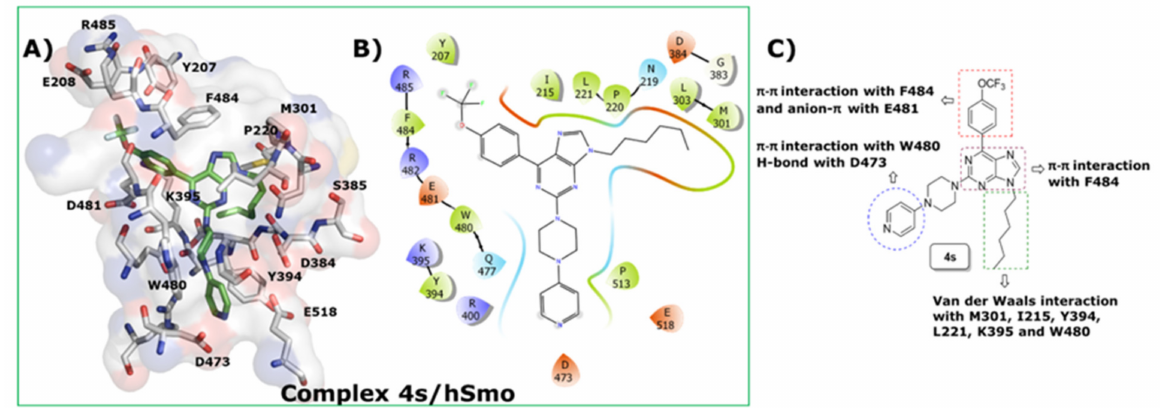
Figure 6. Predicted binding mode of 4s (green) within the α -heptahelical bundle of the hSMO receptor (PDB ID: 4QIN). ( A ) 3D representation of hSMO in complex with 4s ; residues (less than 5.0 Å) are shown in white stick representation. ( B ) 2D representation of 4s in a complex with hSMO. ( C ) Main interactions in the 4s -hSMO complex. Areas of the molecular structure of 4s which are important for its interaction with SMO are marked with dotted